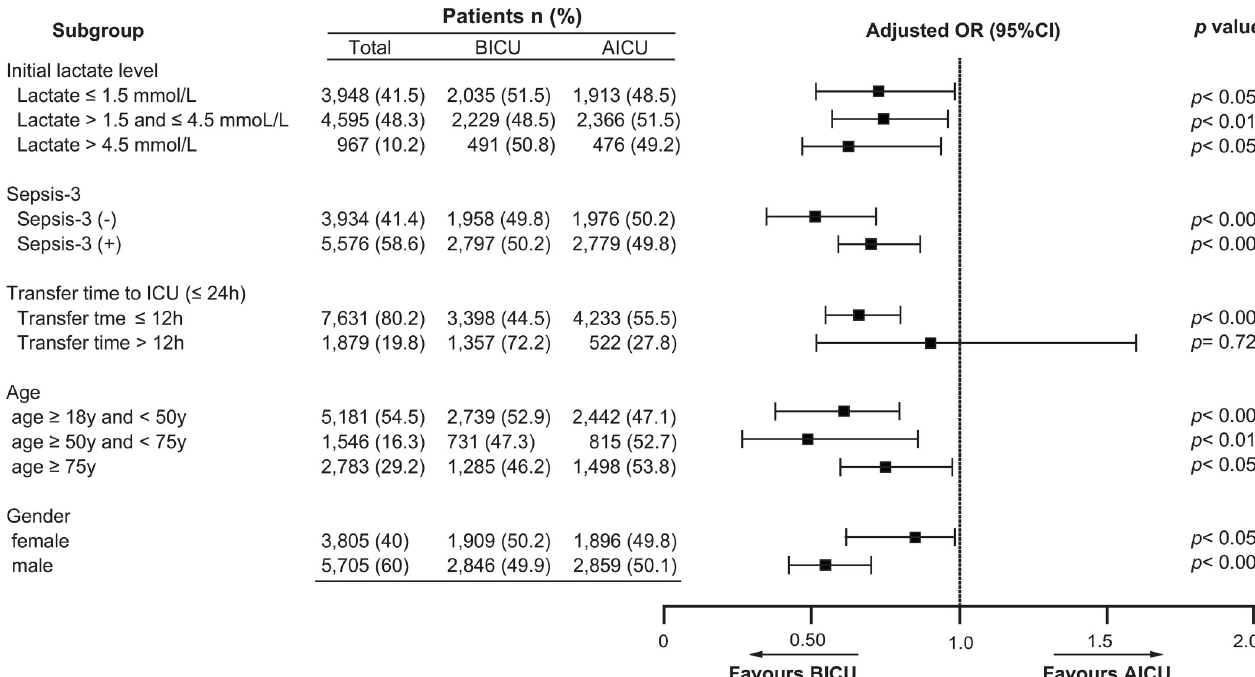
Fig 3. Subgroup analysis of adjusted OR for hospital mortality in the PSM cohort (n = 9,510). OR was adjusted for age, gender, ethnicity, ICU type, admission type, ICU severity scores, CCI, and initial lactate level. Error bars represent 95% confidence intervals.